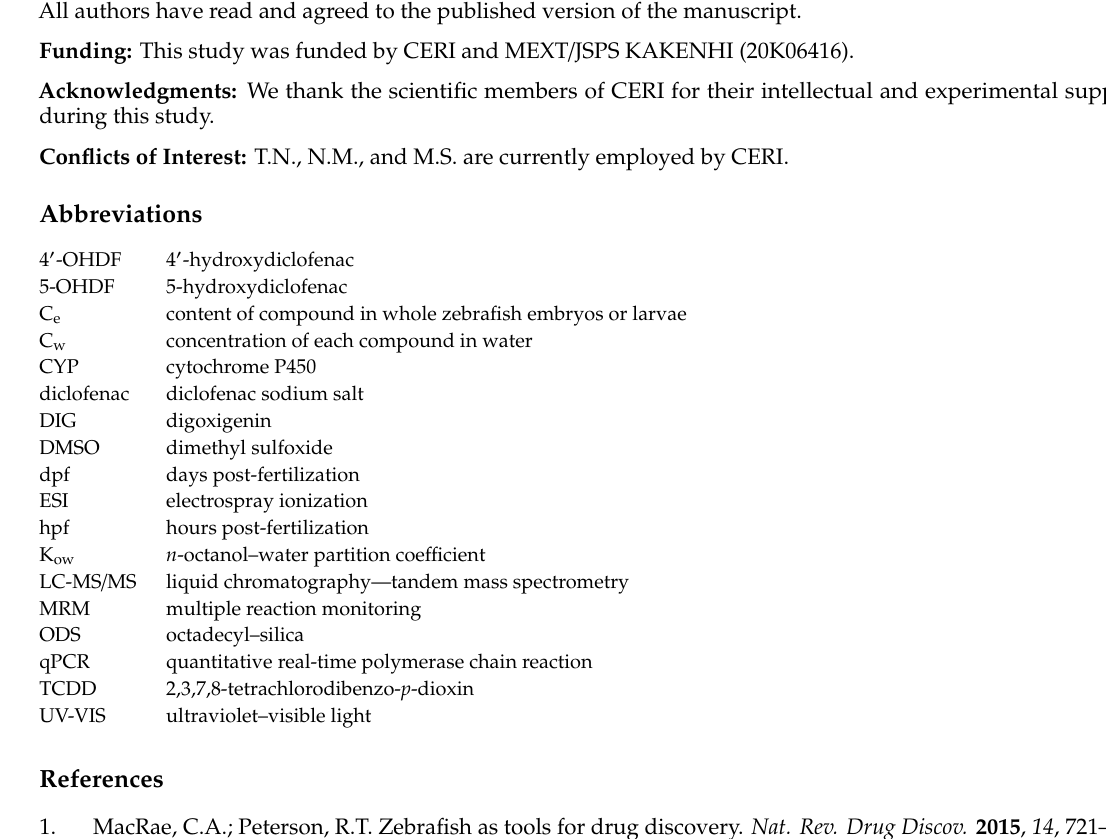
Table S1: Primers used for quantitative real-time PCR, Table S2: Primers used for preparation of probes for in situ hybridization, Figure S1: E ff ects of cytochrome P450 inducers on expression of a several CYP subtypes. Zebrafish embryos or larvae were exposed to 100 µ M rifampicin (R) and 100 µ M β -naphthoflavone (NF) from 26 hpf. VC means vehicle control (0.1% DMSO). cDNAs of larval zebrafish were prepared at 55 hpf for qPCR measurement of some CYP subtypes that showed positive signals by inducers with in situ